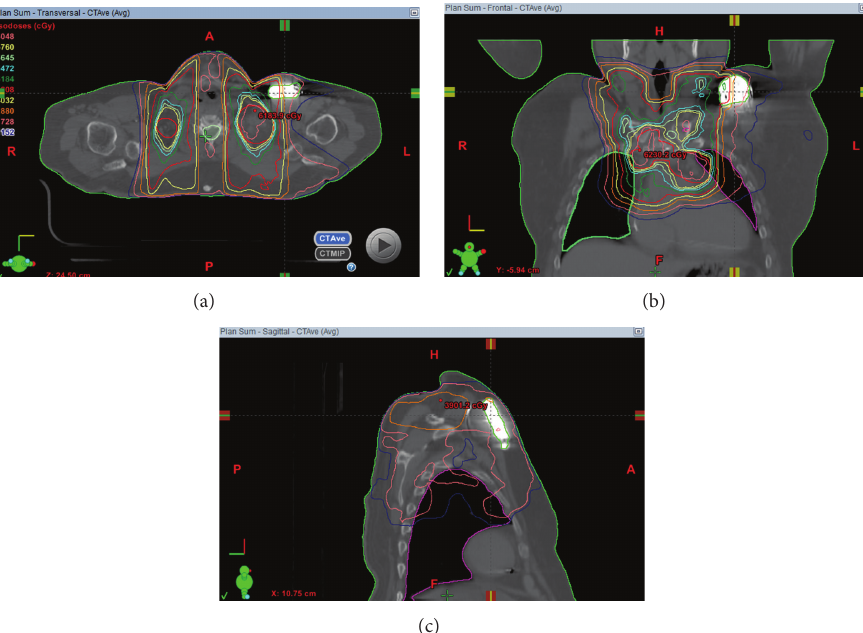
Figure 1: Axial (a), frontal (b), and sagittal (c) CT scans with overlying treatment volumes and corresponding doses outlined in color. AICD shown to be in field of